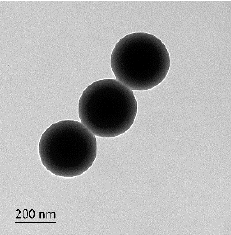
Figure 1. The transmission electron microscopy (TEM) image of core-shell latex spheres of P(St-MMA- AA) with diameters of about 285